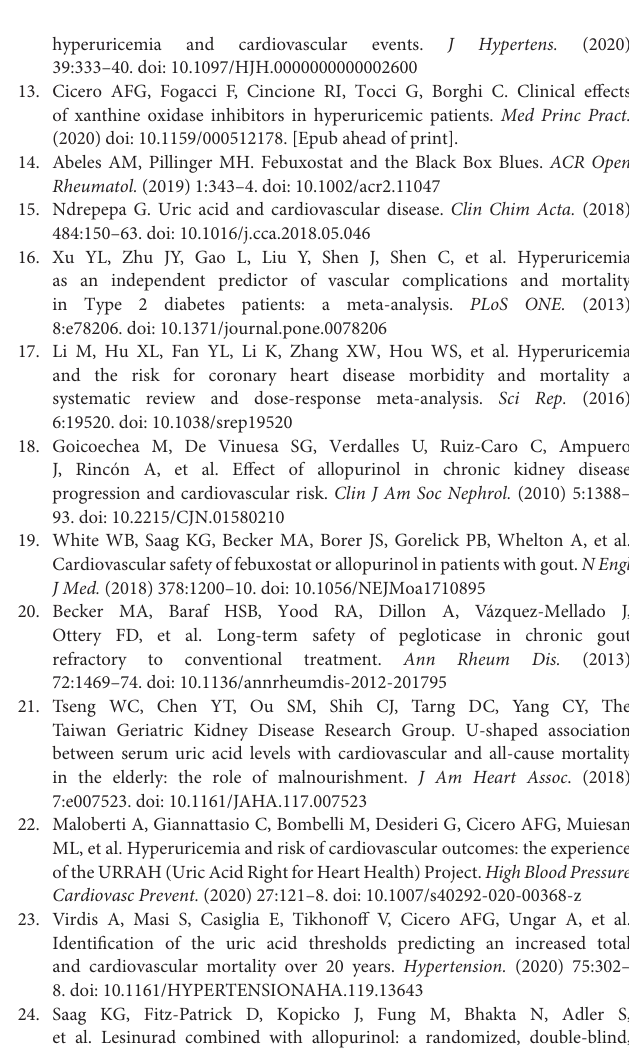
Supplementary Figure 1 | Risk of bias graph. Supplementary Figure 2 | Funnel plot of the publication bias assessment (A) MACEs (B) CVEs. Supplementary Figure 3 | Sensitivity analysis of the “leave-one-out” method: (A) MACEs; (B) CVEs. Supplementary Figure 4 | Sensitivity analysis of the subjects with cardiovascular comorbidities. Supplementary Figure 5 | Sensitivity analysis of the subjects with cardiorenal comorbidities. Supplementary Figure 6 | Sensitivity analysis of the trials with a sample size ≥ 200 and follow-up period ≥ 24 w: (A) MACEs; (B) CVEs. Supplementary Table 1 | Baseline characteristics of the included studies. Supplementary Table 2 | Search